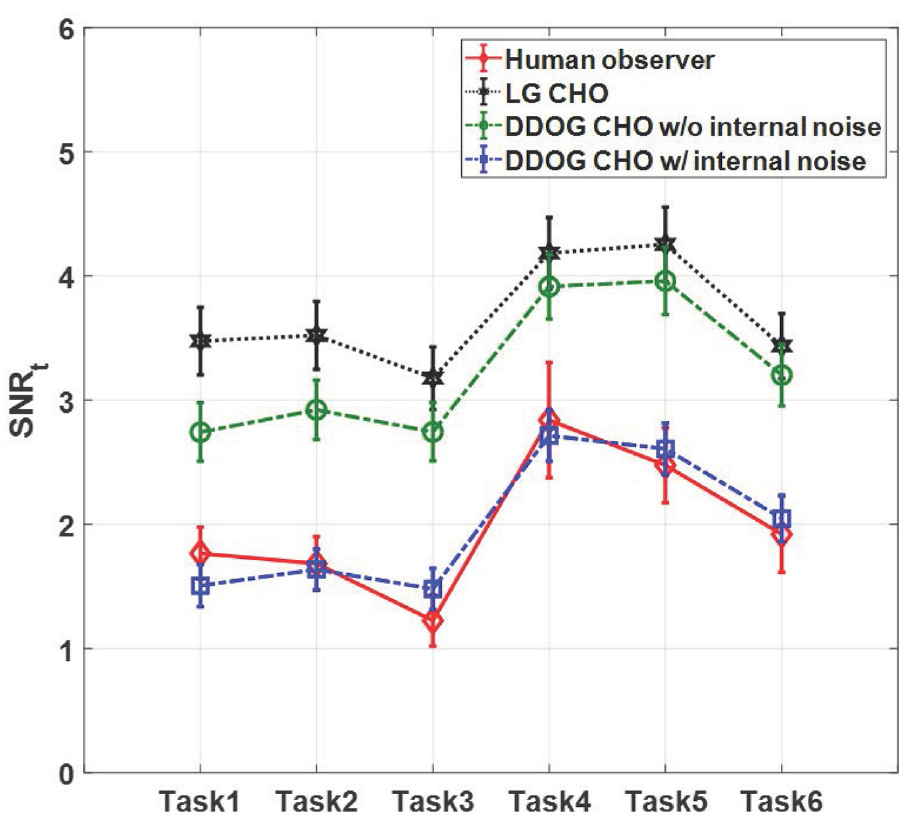
Fig 6. SNR t values of human and model observers. The SNR t values of the human and model observers with 95% confidence intervals for all tasks.